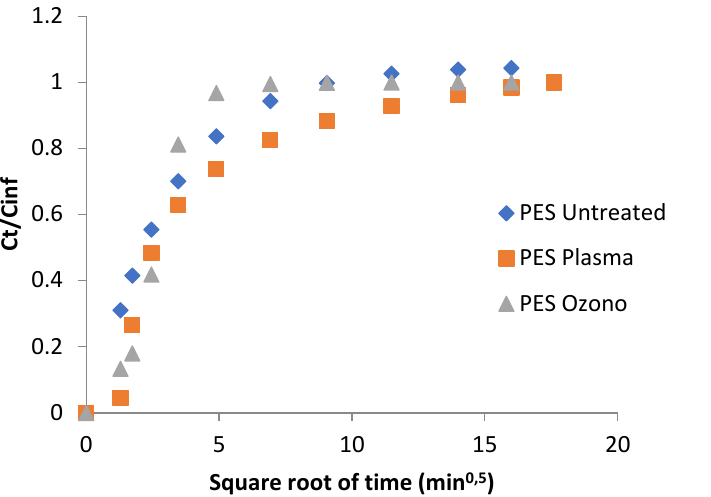
Figure 8. Relative release of lavender oil, for the different square roots of time, from the microcapsules impregnated in polyester fabrics .